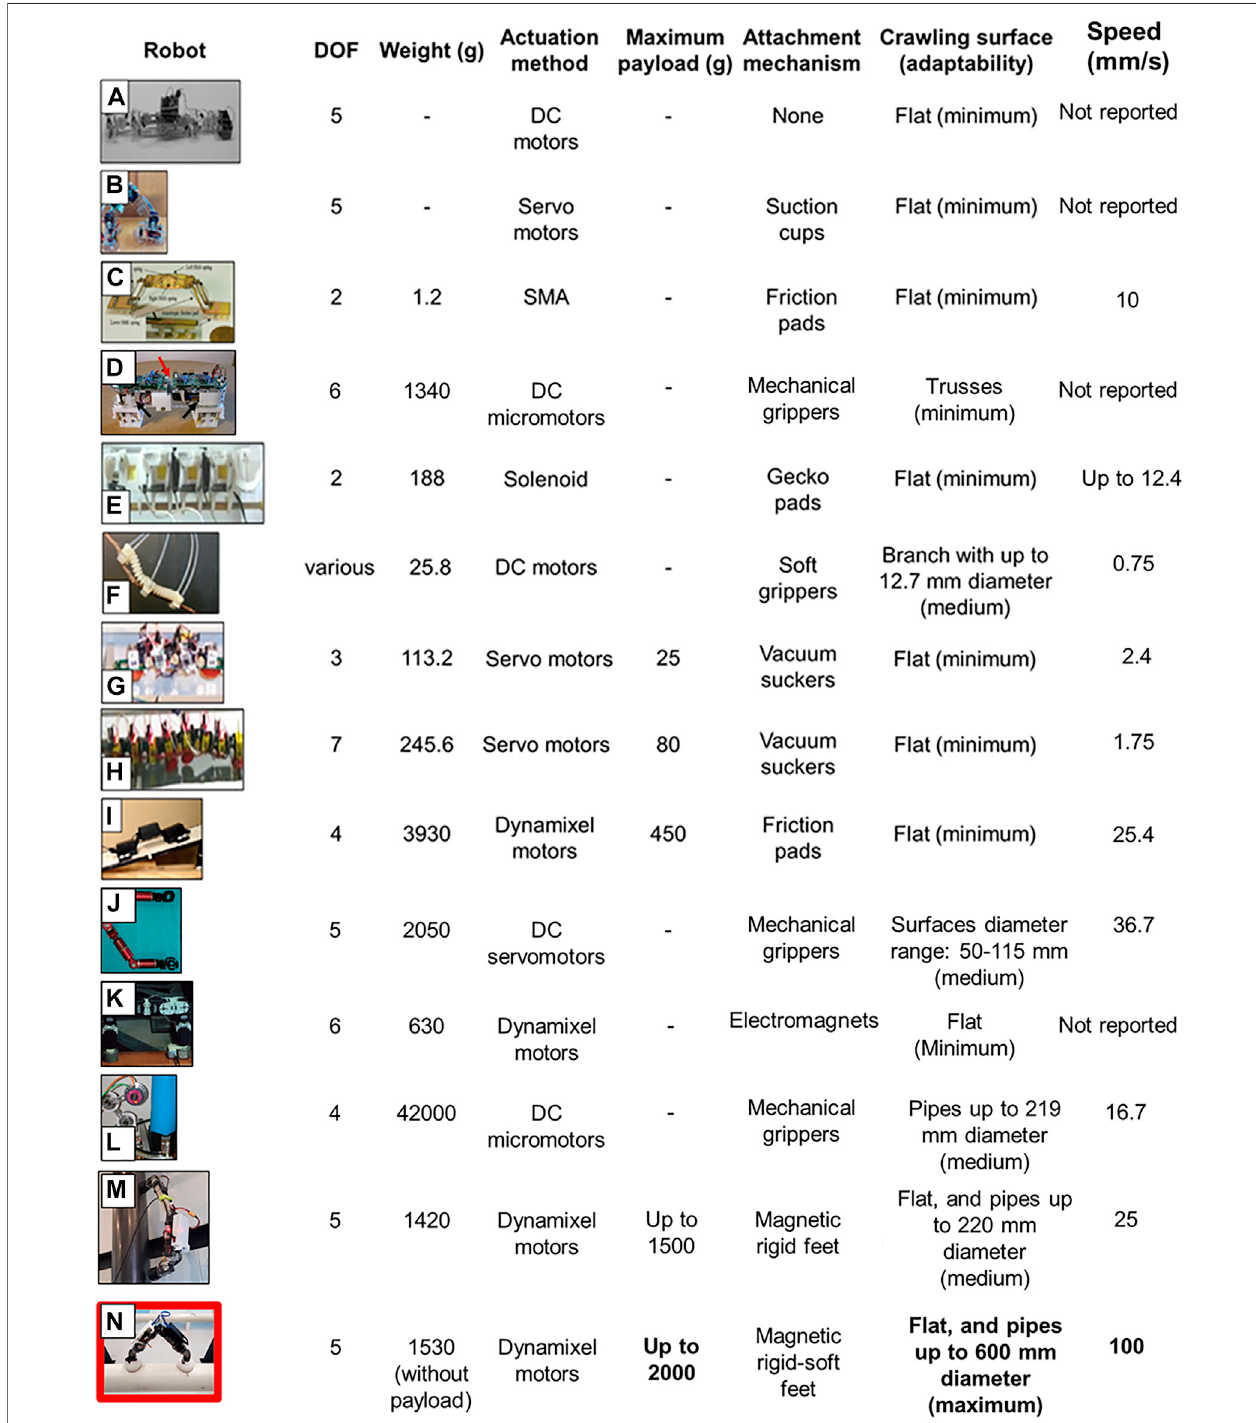
FIGURE 14 | A comparison between different state-of-the-art worm-like robots (A – L) and our robot (M) . The worm-like robots are chosen for comparison based on design diversity, fabrication, and control approaches such that a broader comparative view of the worm-inspired robots can be developed. Our versatile robot relies ontherigid-softmagneticfeettocrawlwithmaximumadaptabilityoncurvedsurfacesofupto600 mmindiameter,carryingacomparativelysuperiorloadtravelingwitha higherspeed.Otherrobotsshownherearereportedfromtheliteratureinthefollowing: (A) reportedinAvilaetal(2006), (B) inYuanetal.(2016), (C) inKohandCho (2012), (D) inYoonandDaniela(2007), (E) inHanetal.(2017), (F) inRozen-Levyetal.(2019), (G) inWangetal.(2009), (H) inWangetal.(2009), (I) inMoreiraetal.(2018), (J) in Guan et al. 2016), (K) in Bi et al. (2012), and (L) in Tavakoli et al. (2008). (M) is the previous version of iCrawl robot reported in Khan et al. 2020), whereas (N) is our latest version of iCrawl